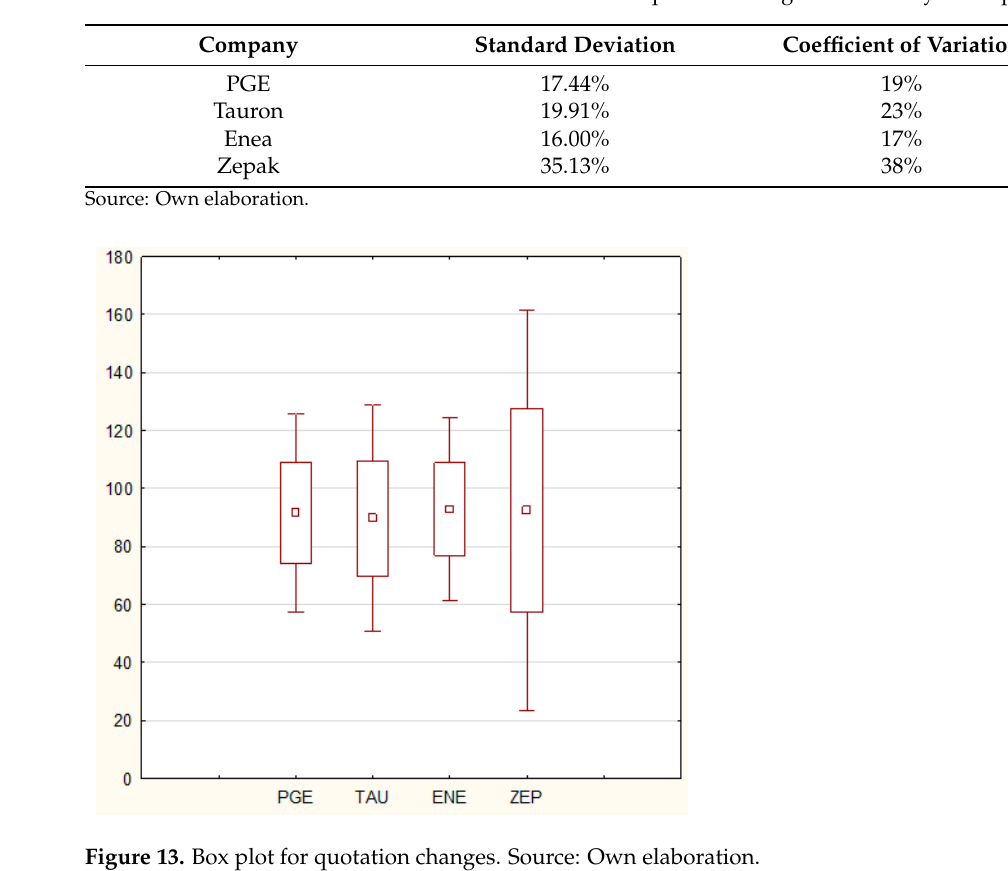
Figure 12. Dendrogram grouping the surveyed companies in terms of quotation changes. Source: Own elaboration. Table 6. Coefficients of variation and standard deviations for quotation changes of the surveyed companies.